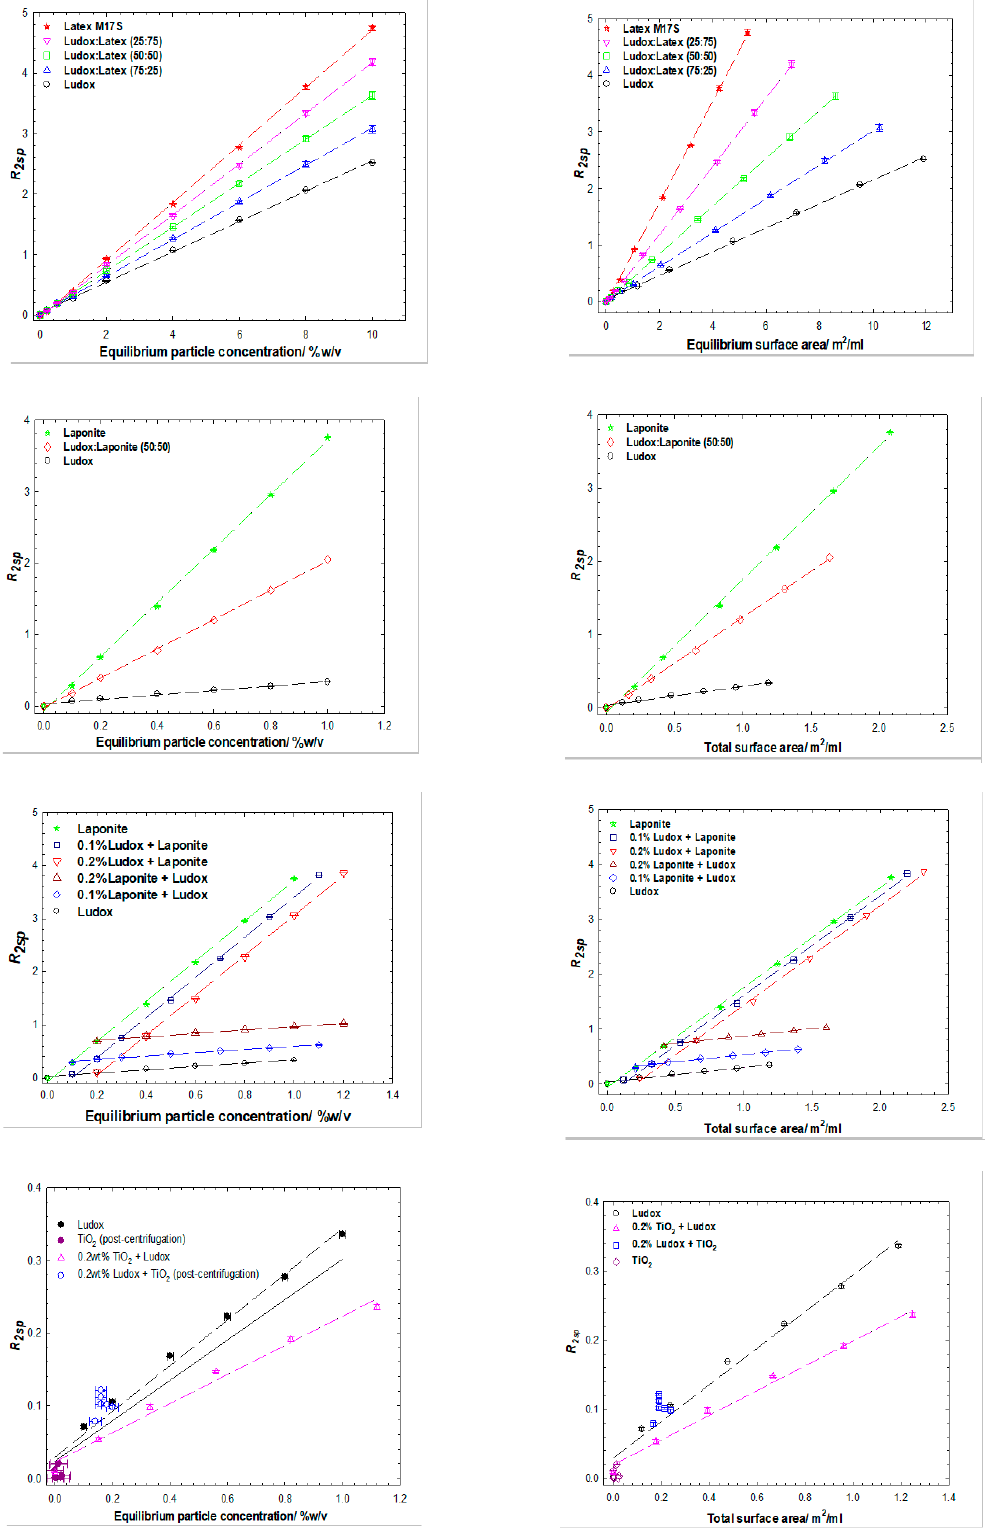
Figure 2. Specific relaxation rates as a function of the equilibrium particle concentration (left column) and surface area (right column) for binary particle mixtures of Ludox and latex ( top ), Ludox and laponite, ( middle two rows) Ludox and TiO 2 ( bottom row). The TiO 2 samples have been gently centrifuged to remove the TiO 2 component.